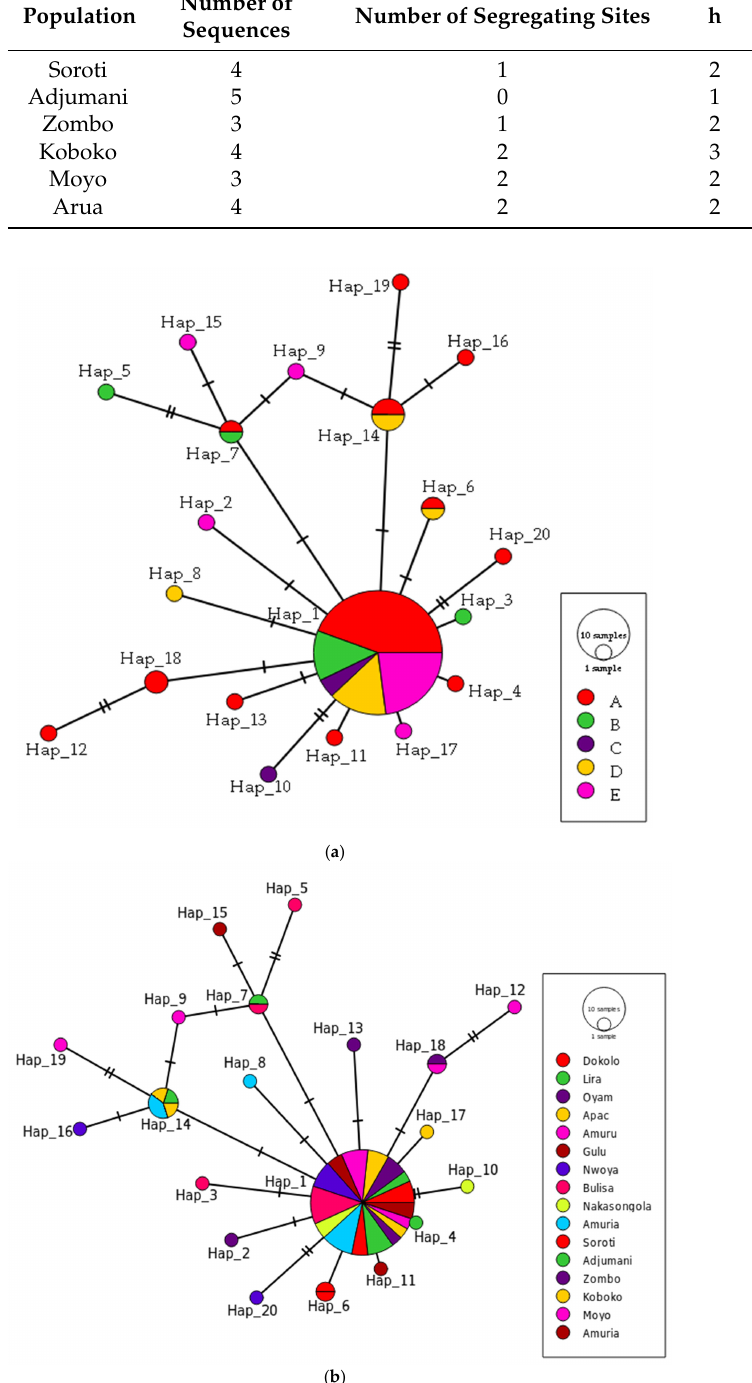
Figure 3. Minimum spanning haplotype network showing evolutionary relationships among haplotypes in different agro-ecological zones ( a ), and different districts ( b ). Each small black line along a connecting line represents a change of one base pair. Haplotypes are colour coded according to the population. In haplotype network ( a ) (red represents population (A) Northern moist farmlands, green represents population (B) Western mid-altitude farmlands, purple represents population (C) Central wooden savannah, yellow represents population (D) Southern and Eastern Lake Kyoga basin and pink represents population (E) North-western farmlands). Circle sizes correspond to the haplotype